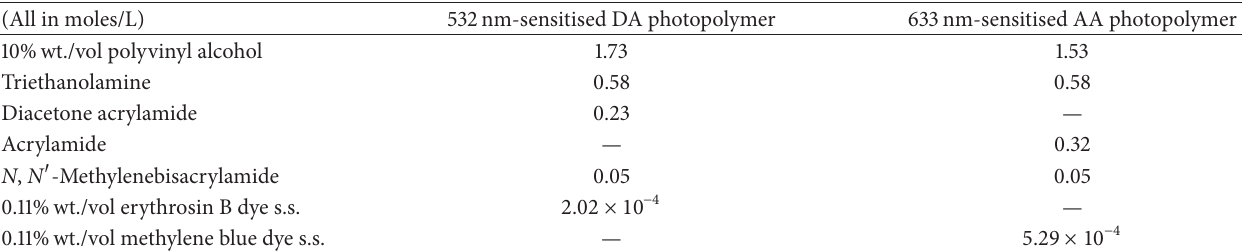
Figure 2: (a) Reference frame, produced by capturing the beam reconstructed from the hologram recorded in the red sensitive layer. (b) Result of subtraction of the reference frame from the current frame (before switching on the green laser). (c) Fringes visible as a result of subtraction of the reference frame from the current frame (after switching on the green laser). Table 1: DA and AA photopolymer solutions for shrinkage